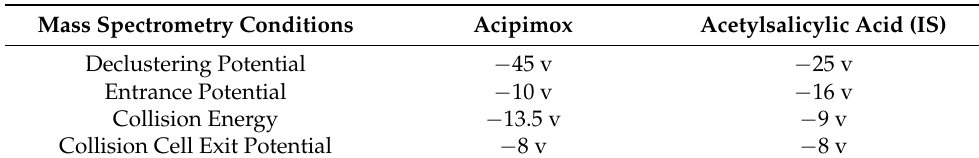
Table 1. The mass spectrometry conditions of acipimox and IS.